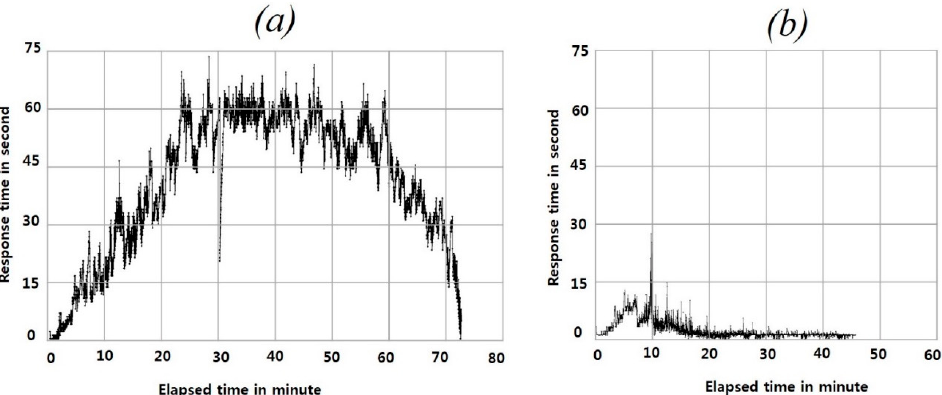
Figure 6. Performance measurement with the MAF algorithm in a cloud computing environment: ( a ) single virtual server without auto-scaling; ( b ) auto-scaled virtual servers.